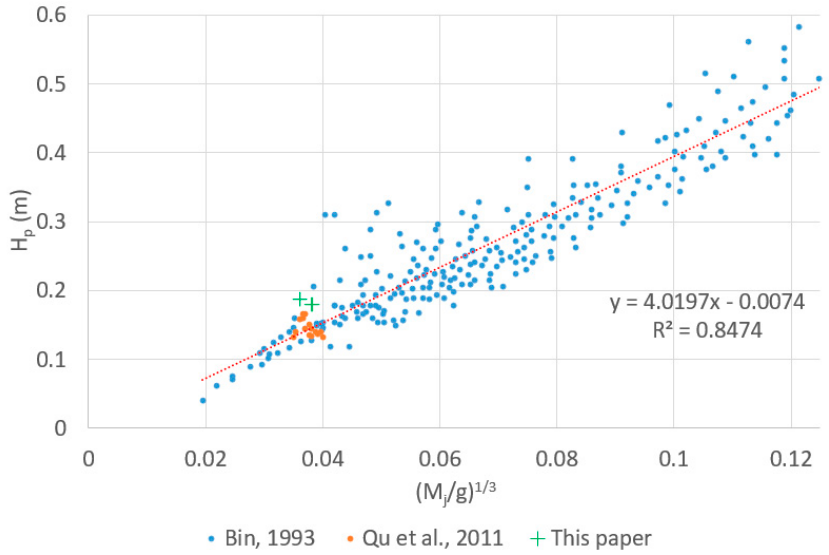
(cid:18) (cid:19) 1/3 M j (cid:2778) (cid:2780)⁄ in the range of applicability of Equation (cid:2169) (cid:2192) (cid:4673) in the range of applicability of Equation g (cid:2189)